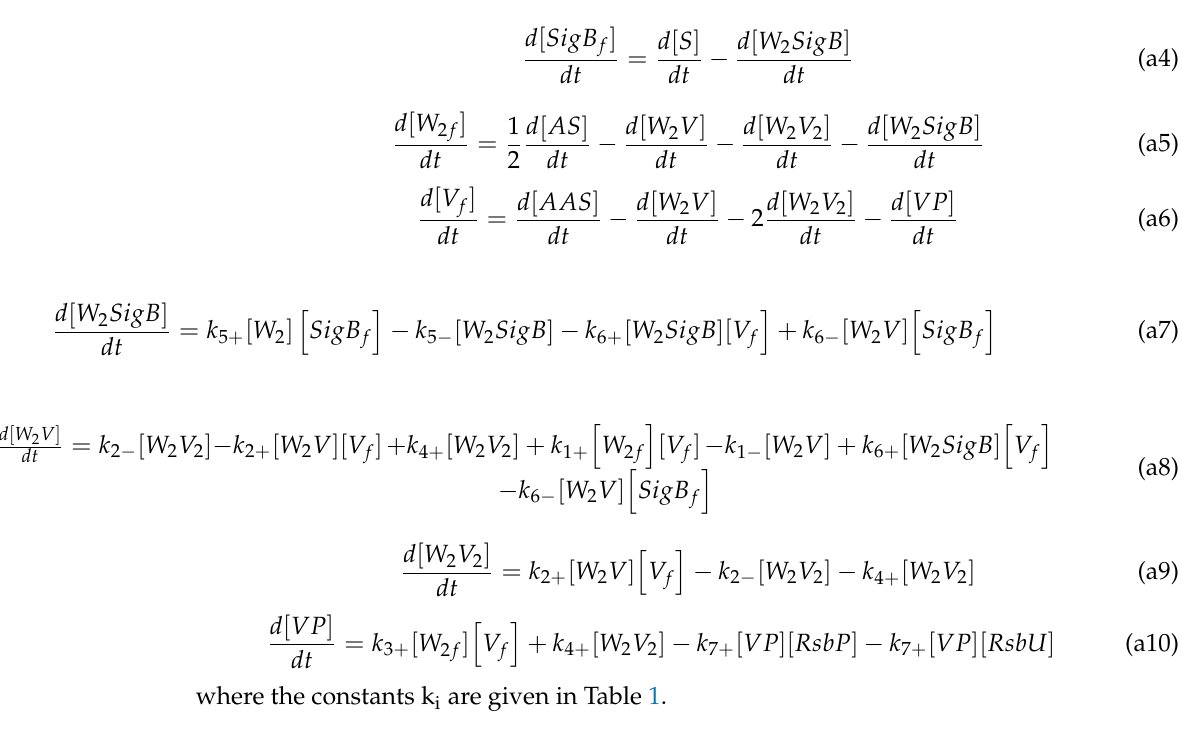
Table 1. Kinetic constants [9] scaled and converted to min − 1 to fit microarray-measured expression profiles